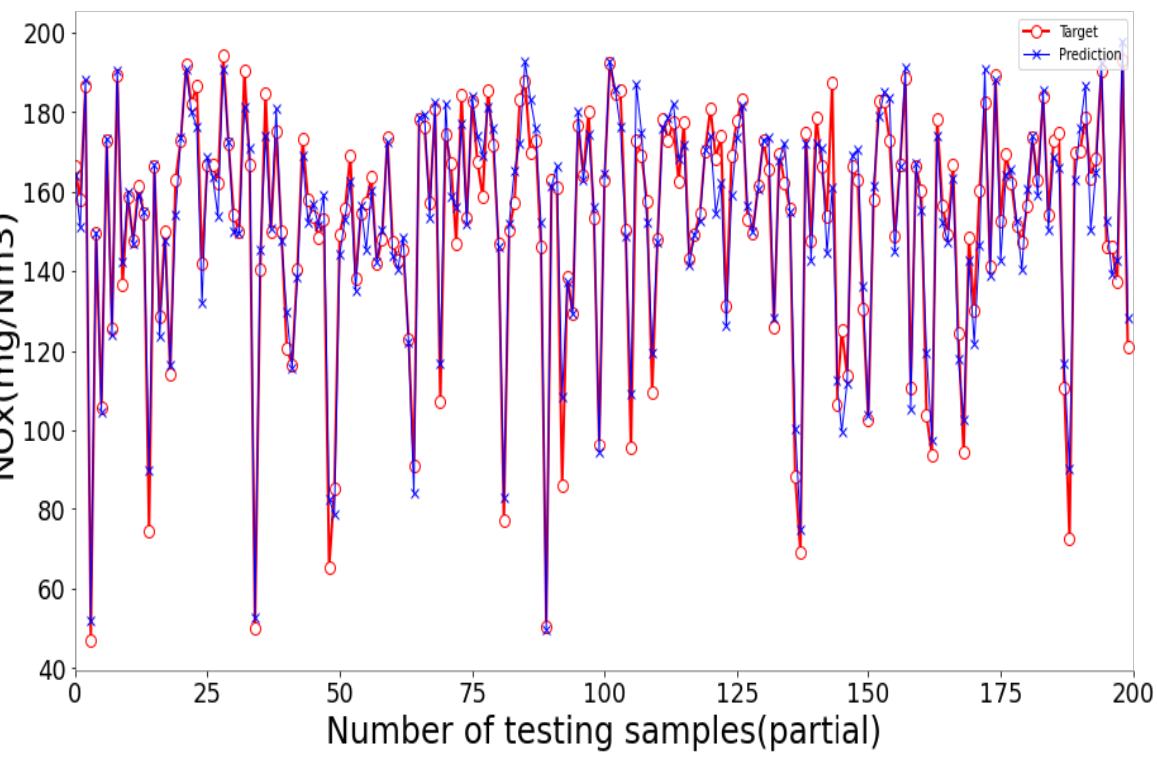
Figure 4. The fitting diagram of NOx emission concentration model.